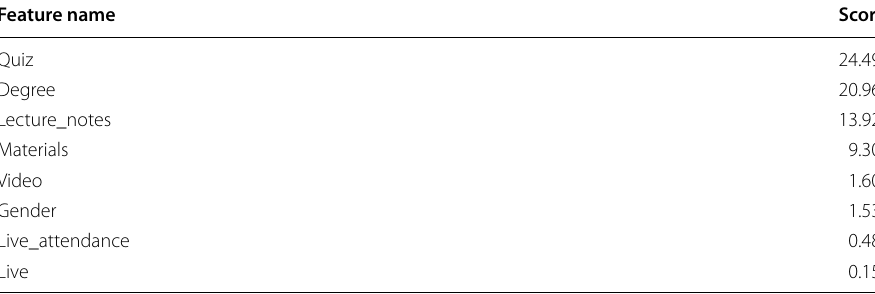
Table 3 SelectKBest test scores of the features in the student data